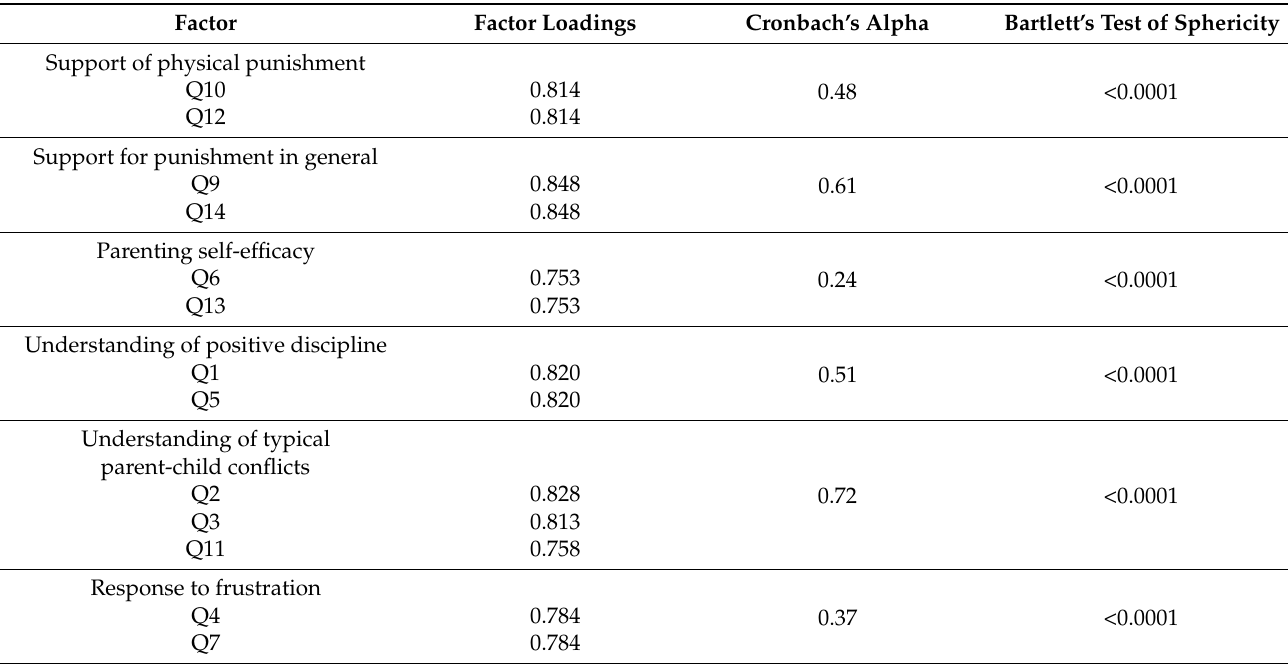
Table 2. Items retained following principal component analysis and factor